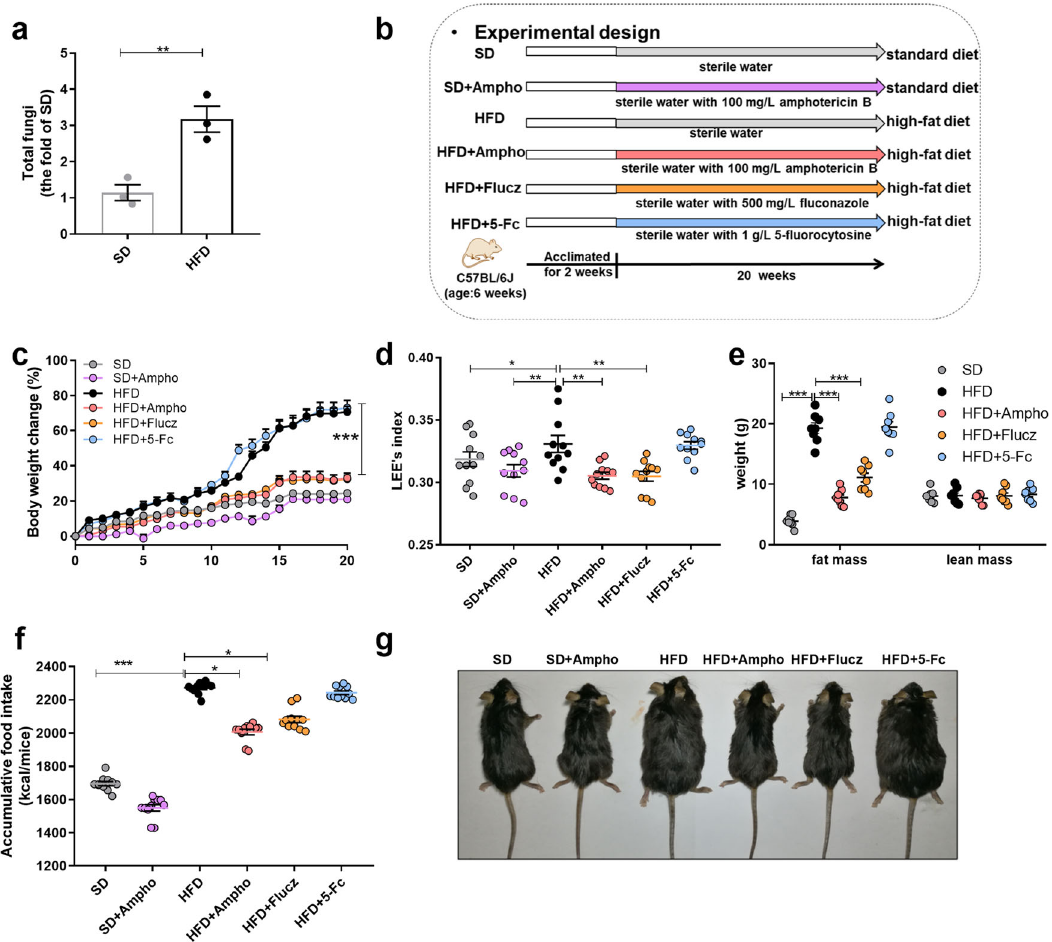
Fig. 1 Oral administration of Amphotericin B or fl uconazole suppressed the obesity in HFD-fed mice. a Total fungi in feces were assessed by qPCR; b experimental design; c weight gain; d LEE ’ s index; e the weight of fat mass and lean mass; f accumulative food intake; g macroscopic views of mice. SD, standard diet-fed mice group; SD + Ampho, standard diet-fed mice treated with amphotericin B; HFD, high-fat diet-fed mice group; HFD + Ampho, high-fat diet-fed mice treated with amphotericin B; HFD + Flucz, high-fat diet-fed mice treated with fl uconazole; HFD + 5-Fc, high-fat diet-fed mice treated with 5- fl uorocytosine. Data are presented as the mean ± SEM. a N = 3 mice per group, c − f N = 8 − 11 mice per group. Statistical analysis was performed using one-way ANOVA followed by the Tukey post hoc test for ( a , d − f ), and two-way ANOVA followed by the Bonferroni post hoc test for ( c ). * p < 0.05; ** p < 0.01; *** p < the enrichment of C. parapsilosis is closely associated with the occurrence and development of diet-induced obisity. Further- more, we con fi rmed that C. parapsilosis is sensitive to both